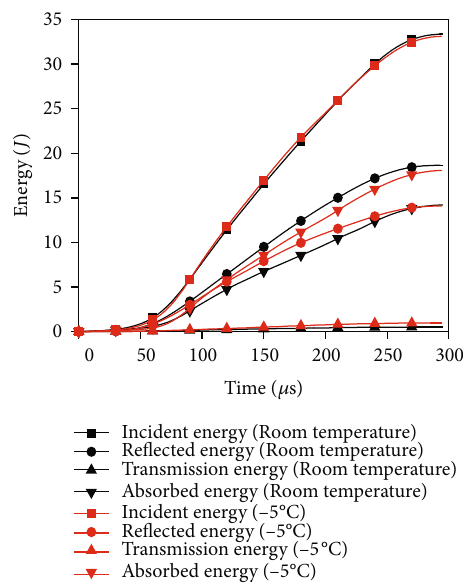
Figure 7: Energy distribution of natural